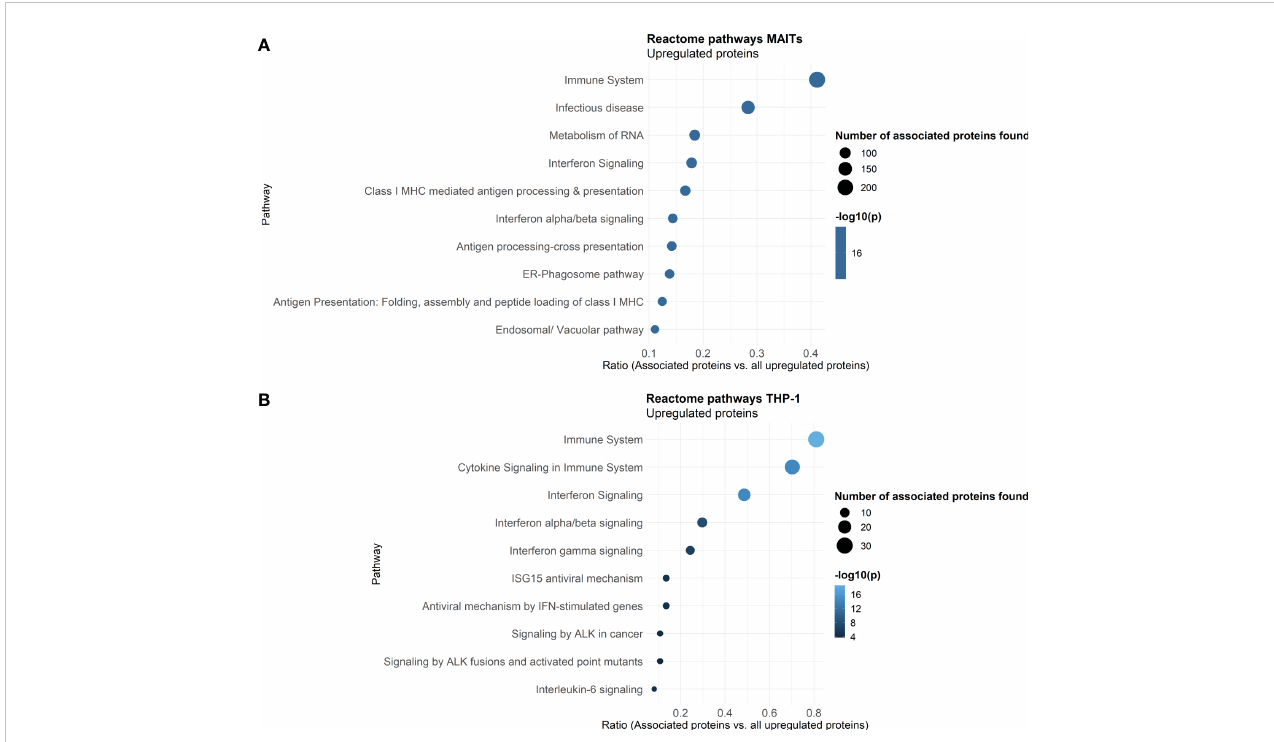
FIGURE 4 Reactome Pathway analysis of 5-OP-RU stimulated MAIT and THP-1 cells. Pathway analysis of translatome data. Differentially upregulated proteins (except low-con fi dent proteins) from MAIT cells (A) and THP-1 cells (B) stimulated in the bicellular system were analyzed. The top ten enriched pathways sorted by p-values are shown. Dot size represents the number of proteins upregulated in the pathway, color represents the statistical signi fi cance of the pathway upregulation, x-axis represents the ratio of upregulated proteins in this pathway in comparison to all analyzed upregulated proteins, y-axis shows the Pathway name. P-values were determined by the Reactome database using hypergeometric distribution and corrected for false discovery rate using the Benjamini-Hochberg